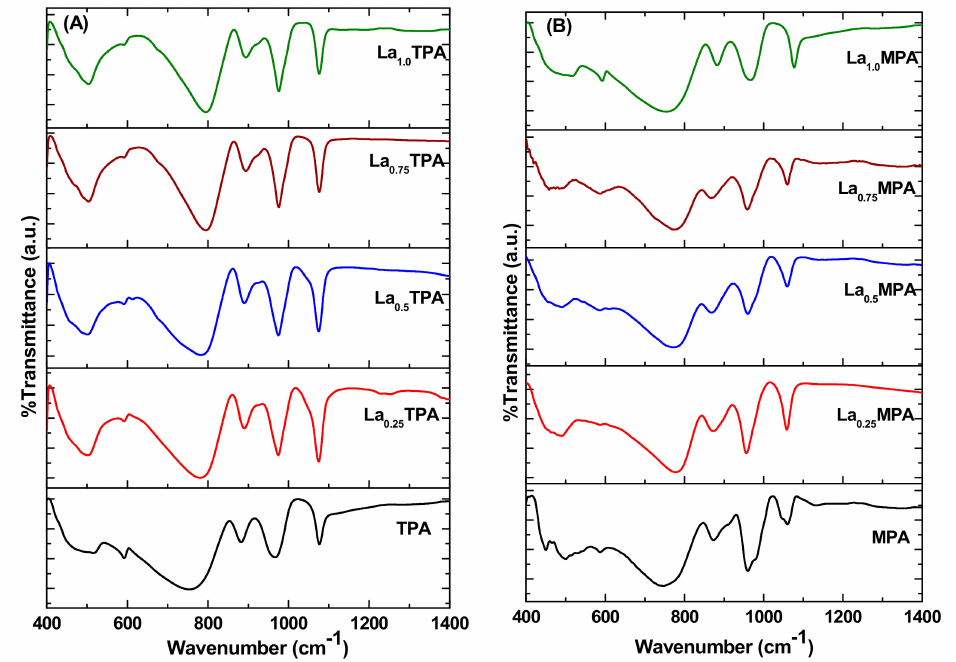
Figure 2. FT-IR spectra of ( A ) La x TPA and ( B ) LA x MPA